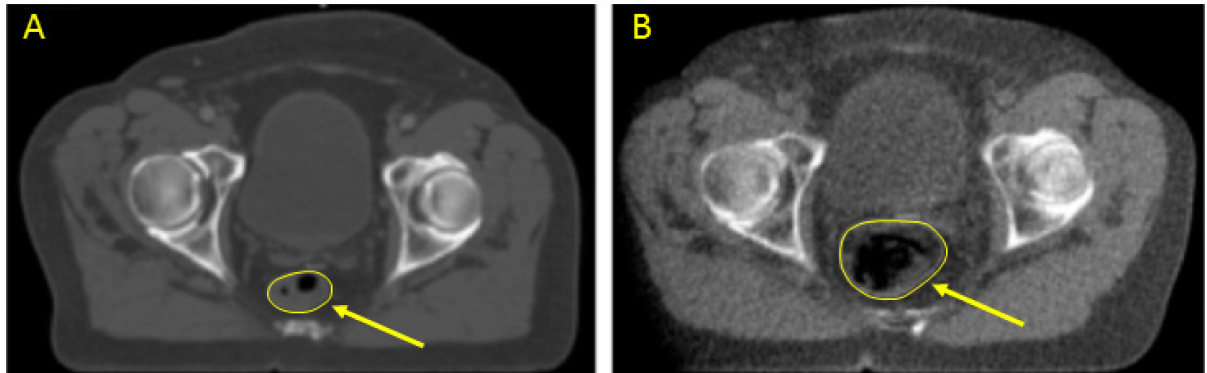
Fig. 1. Planning kV CT scan (A) and scan-of-the day image guidance TomoTherapy HiArt™ MV CT scan (B), at the same level in the same patient receiving curative radiotherapy for prostate cancer. Note that the rectum (arrowed) is of modest size at the time of the planning scan, but dilated principally with air in the treatment scan.